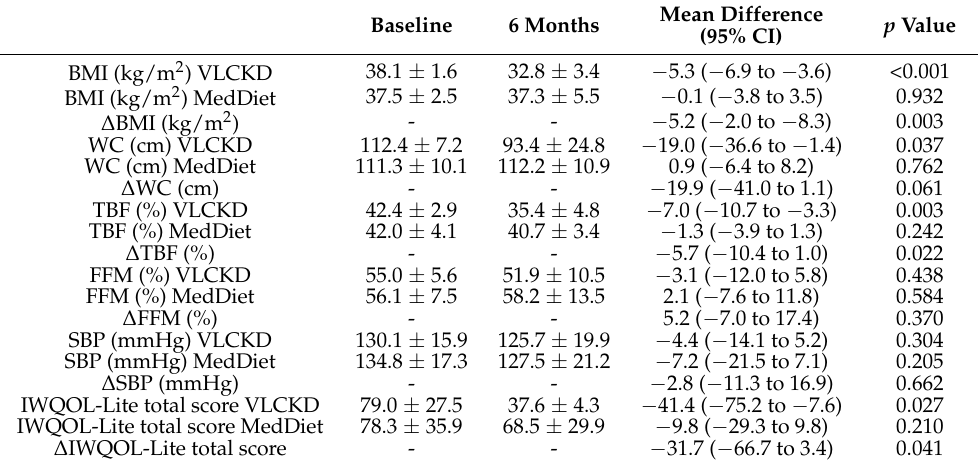
Table 2. Changes in the anthropometric parameters, body composition, and quality of life between baseline and the 6-month follow-up, according to study group, and an analysis of treatment effect.